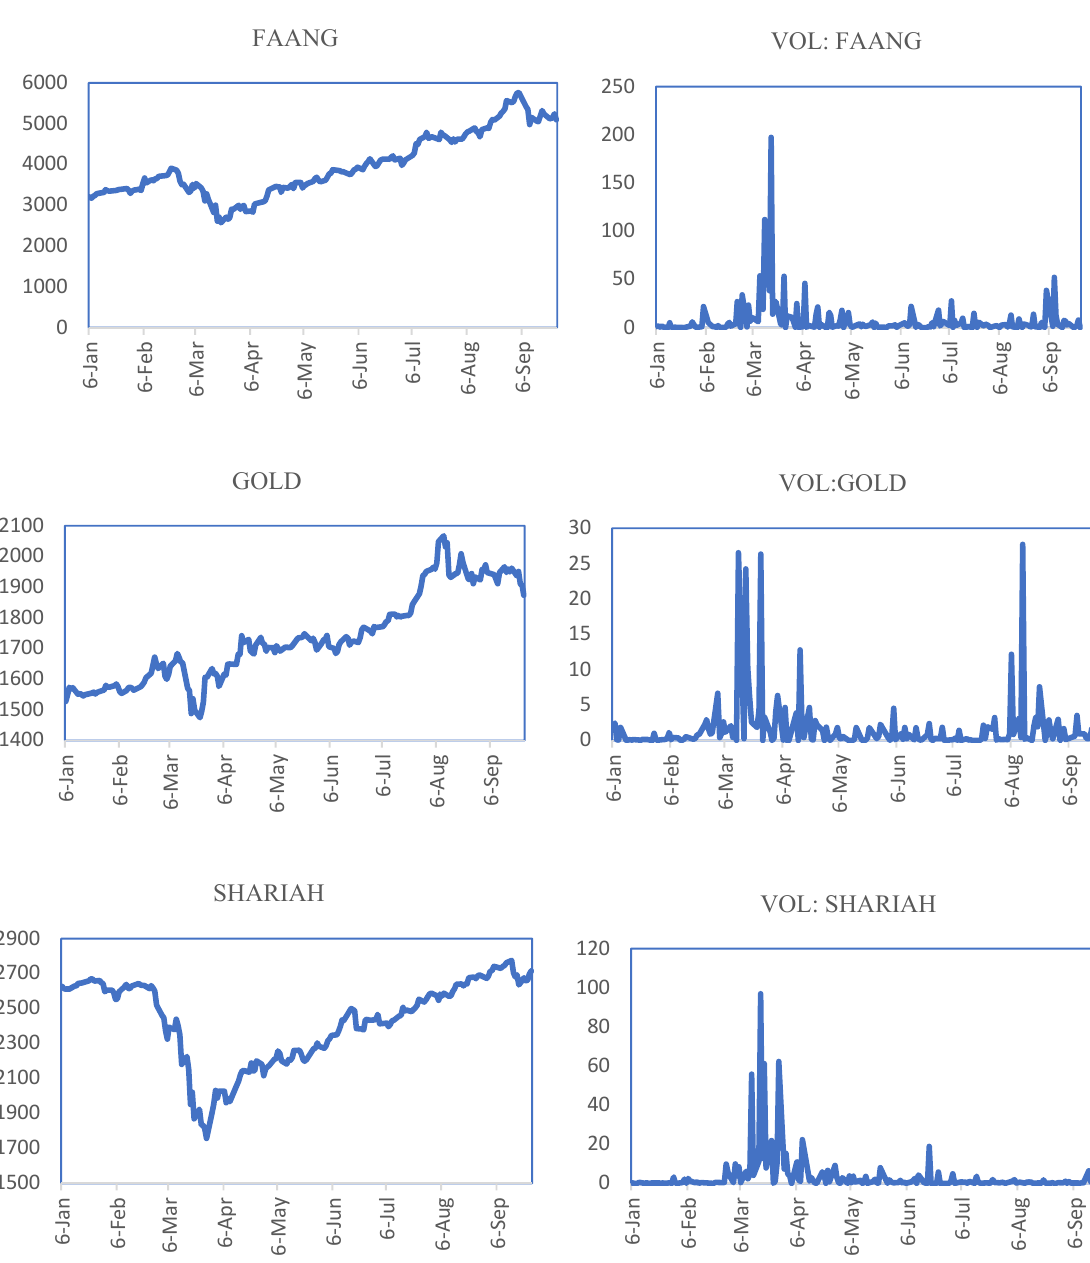
Figure 1. Time-varying hedge ratios computed from the DCC model.